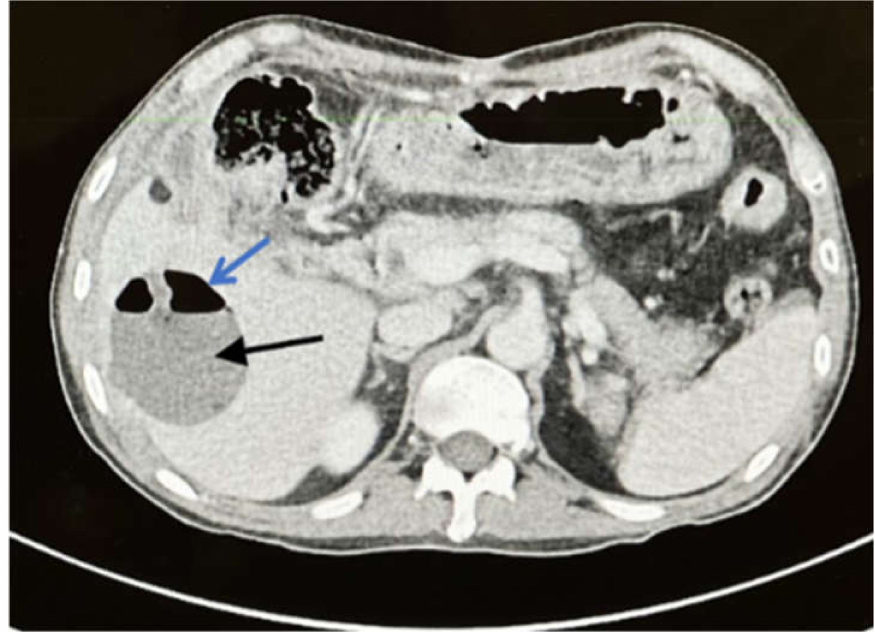
Figure 4. Axial CT scan with delayed contrast phase shows 4 × 3 cm hypo-dense lesion ( black arrow ) with air fluid level ( blue arrow ) in segment six which is characteristic of liver